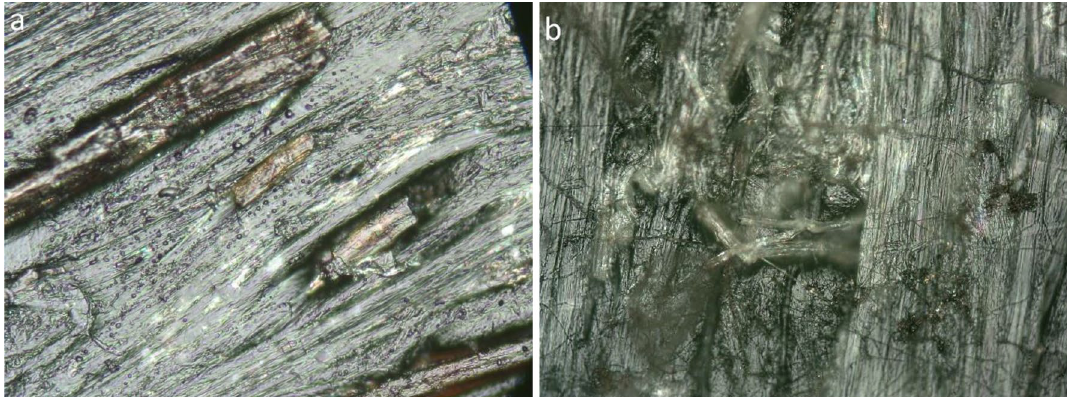
Figure 6. Surface of sample PE/HF2-20/C2-2.5 under magnification 200x; before ( a ) and after saturation ( b ) at 100% RH.